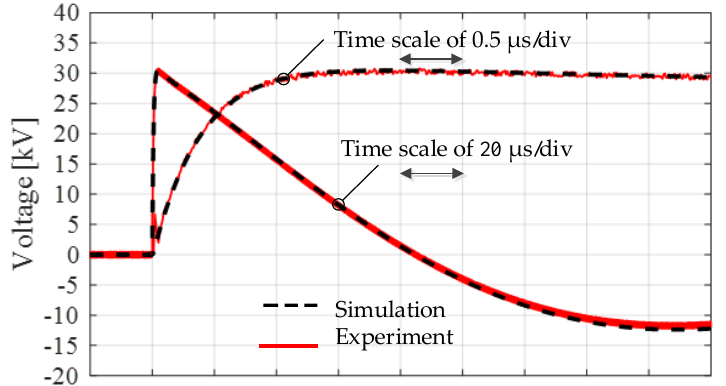
Figure 14. Comparison of the simulation and experimental waveforms in Case 13.